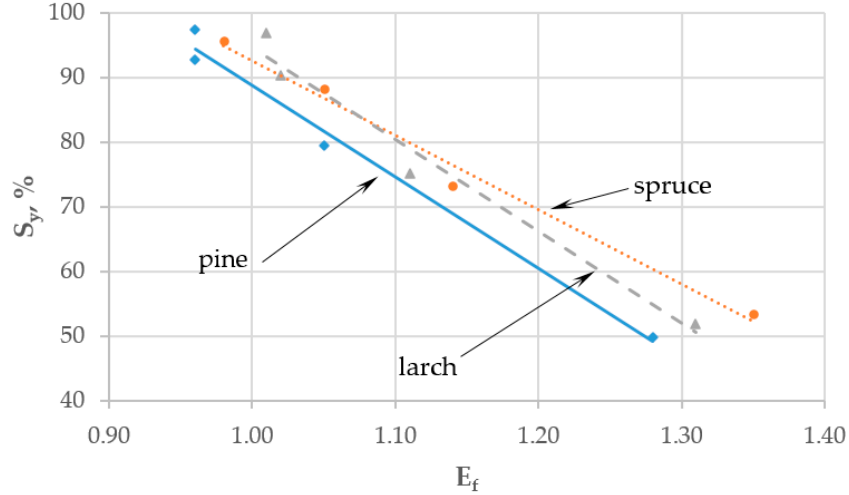
Figure 3. Linear relationships between solid yield ( S y ) and enhancement factor ( E f ) for torrefied cones from three tree species.